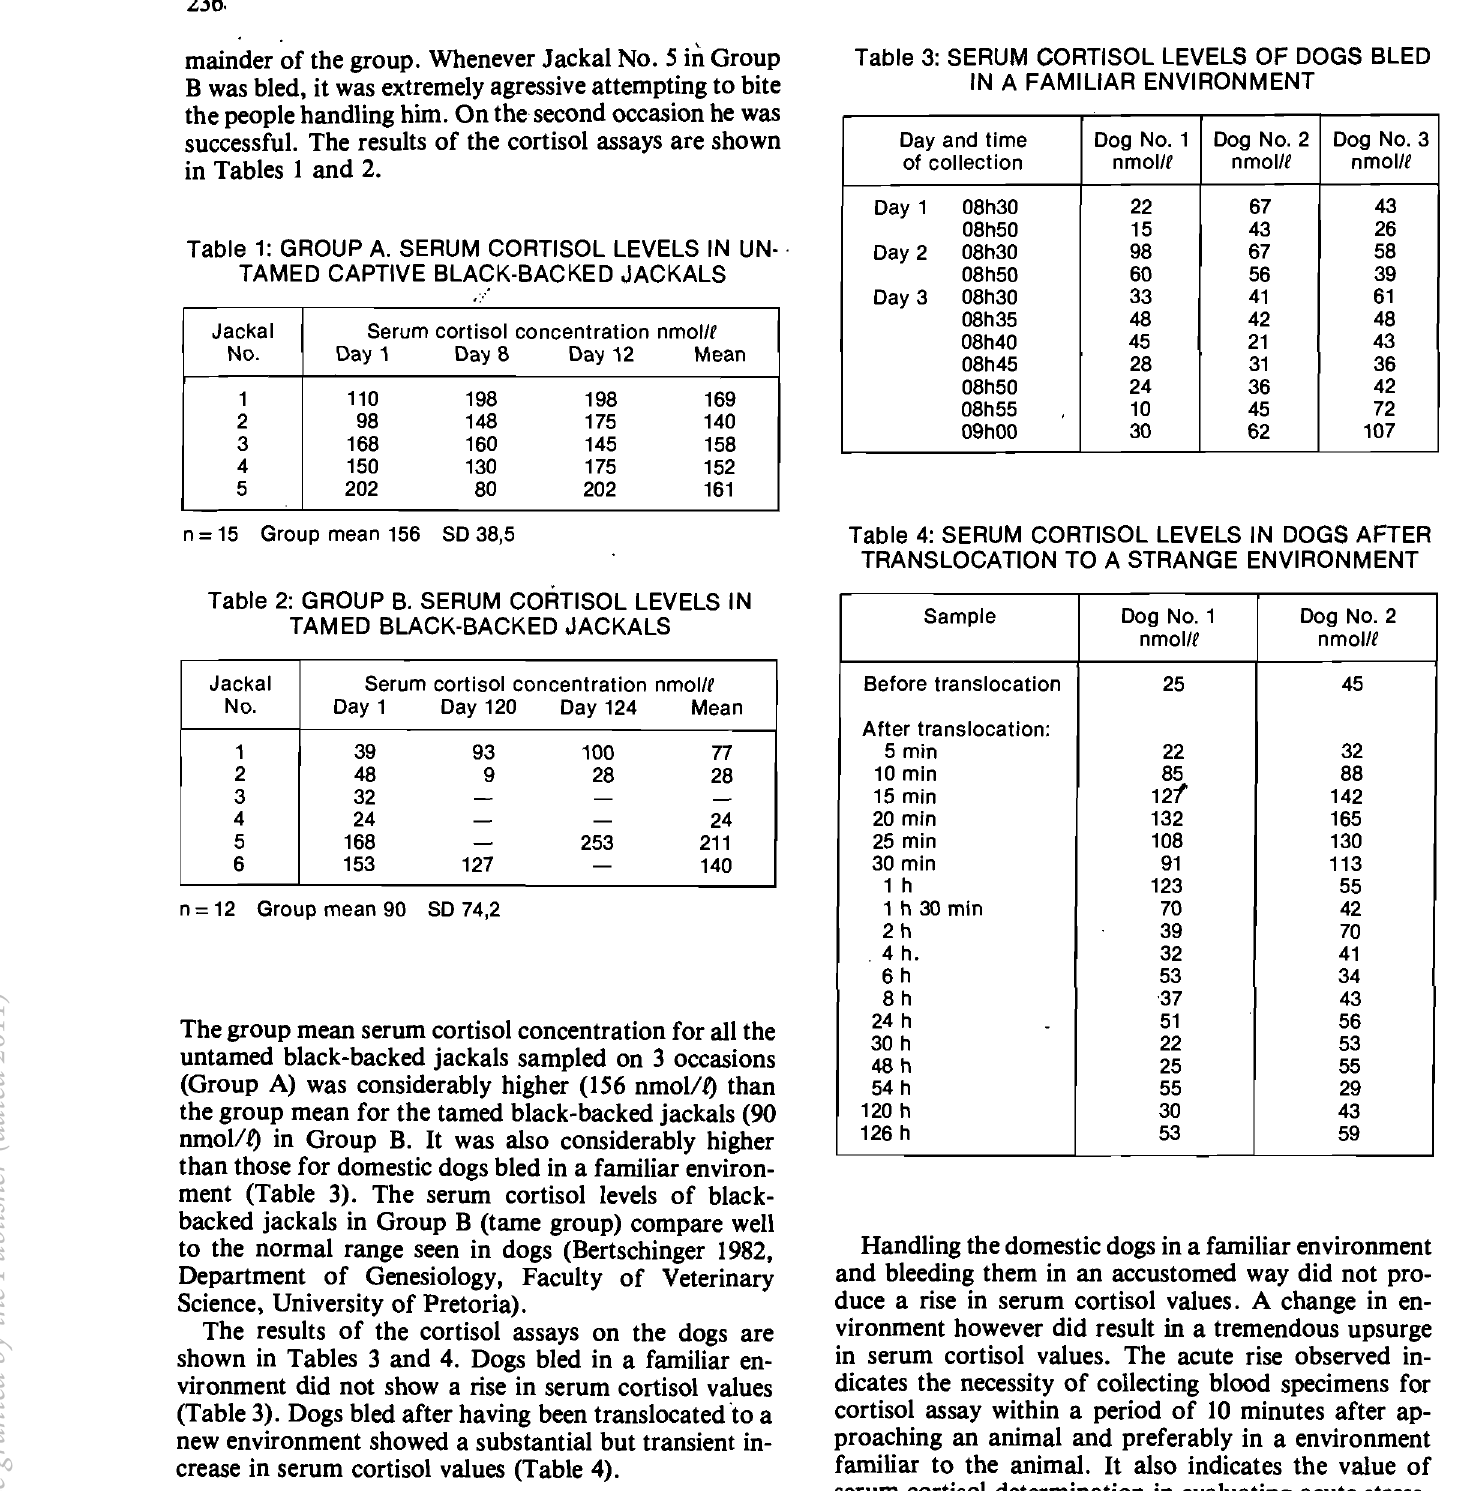
Table 1: GROUP A. SERUM CORTISOL LEVELS IN UN·" TAMED CAPTIVE BLACK·BACKED JACKALS Serum cortisol concentration nmol/t No.